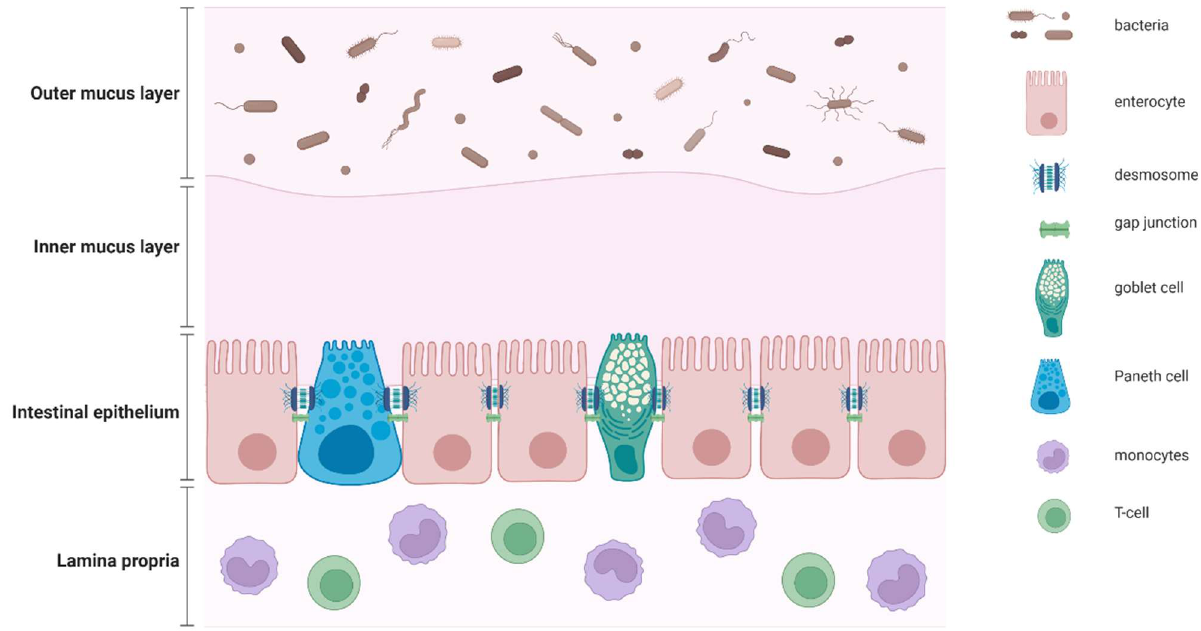
Figure 1. Intestinal mucosal barrier. Epithelial cells, together with Paneth cells and goblet cells, form a layer that acts as a mechanical barrier, which is sealed by a complex combination of desmosomes and gap junctions. The layer of mucus works as a chemical barrier that limits the direct contact between the gut microbiome and the intestinal epithelium. Immune cells are mainly confined to the lamina propria (created with BioRender.com; accessed on 13 December